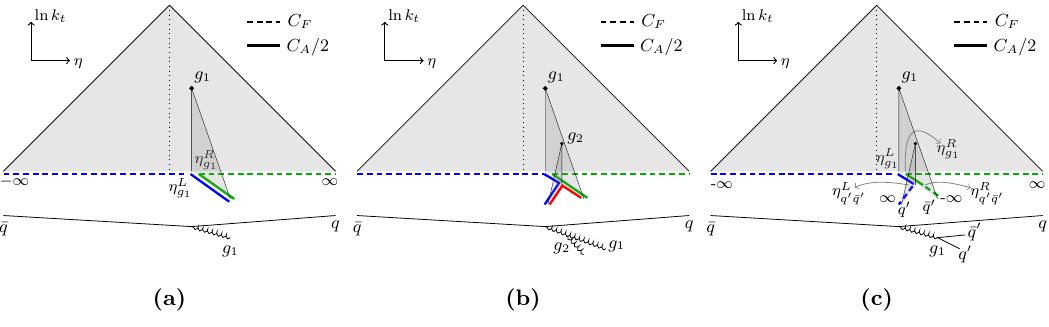
Figure 2. Examples of colour segments and transition points for representative configurations: (a) a q → qg splitting (i.e. the emission of a gluon from a quark segment), (b) a g → gg splitting (i.e. a gluon emission from a gluon segment), and (c) a g → q ¯ q splitting.